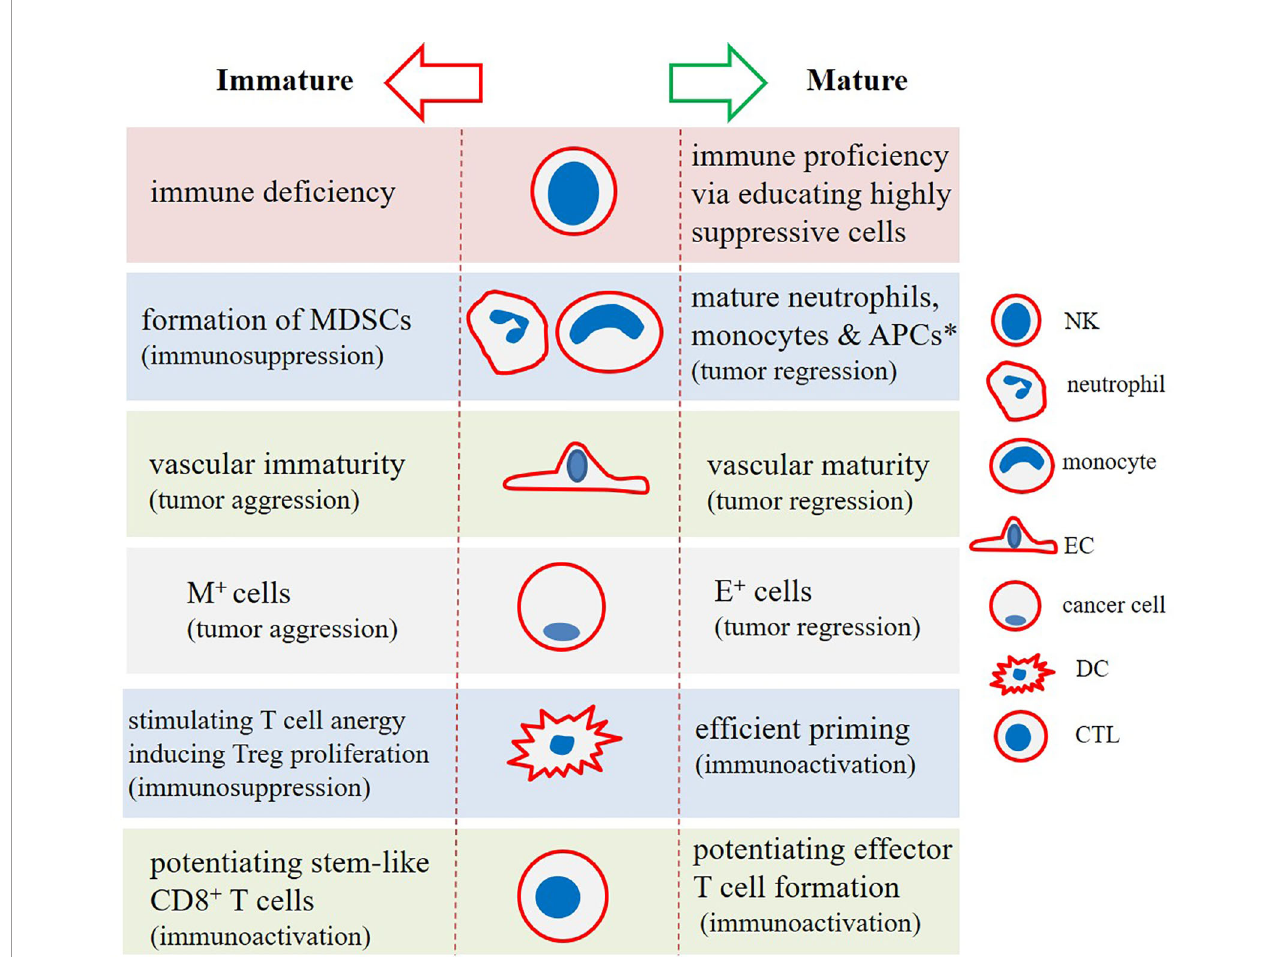
FIGURE 3 | The impact of (im)maturity on fi nal functional state in tumor immune ecosystem. Natural killer (NK) cells, dendritic cells (DCs), and cytotoxic T lymphocytes (CTLs) in a mature cellular state will strengthen immune pro fi ciency against cancer. Stem-like immune niches exist in tumors, strengthening of which will lead to the more effective cancer immunotherapy. Monocytes and neutrophils in an immature state will form myeloid-derived suppressor cells (MDSCs), which act as strong suppressors of the immune system. Similarly, immature endothelial cells (ECs) form aberrant vasculature, which aids tumor progression and relapse. This is also inferable for mesenchymal (M + ) tumor cells (cancer stem cells [CSC] in particular) that represent high resistance and tumor-promoting activities. This contrasts with cells with epithelial-like (E + ) phenotype. *Antigen-presenting cells (APCs) including DCs and